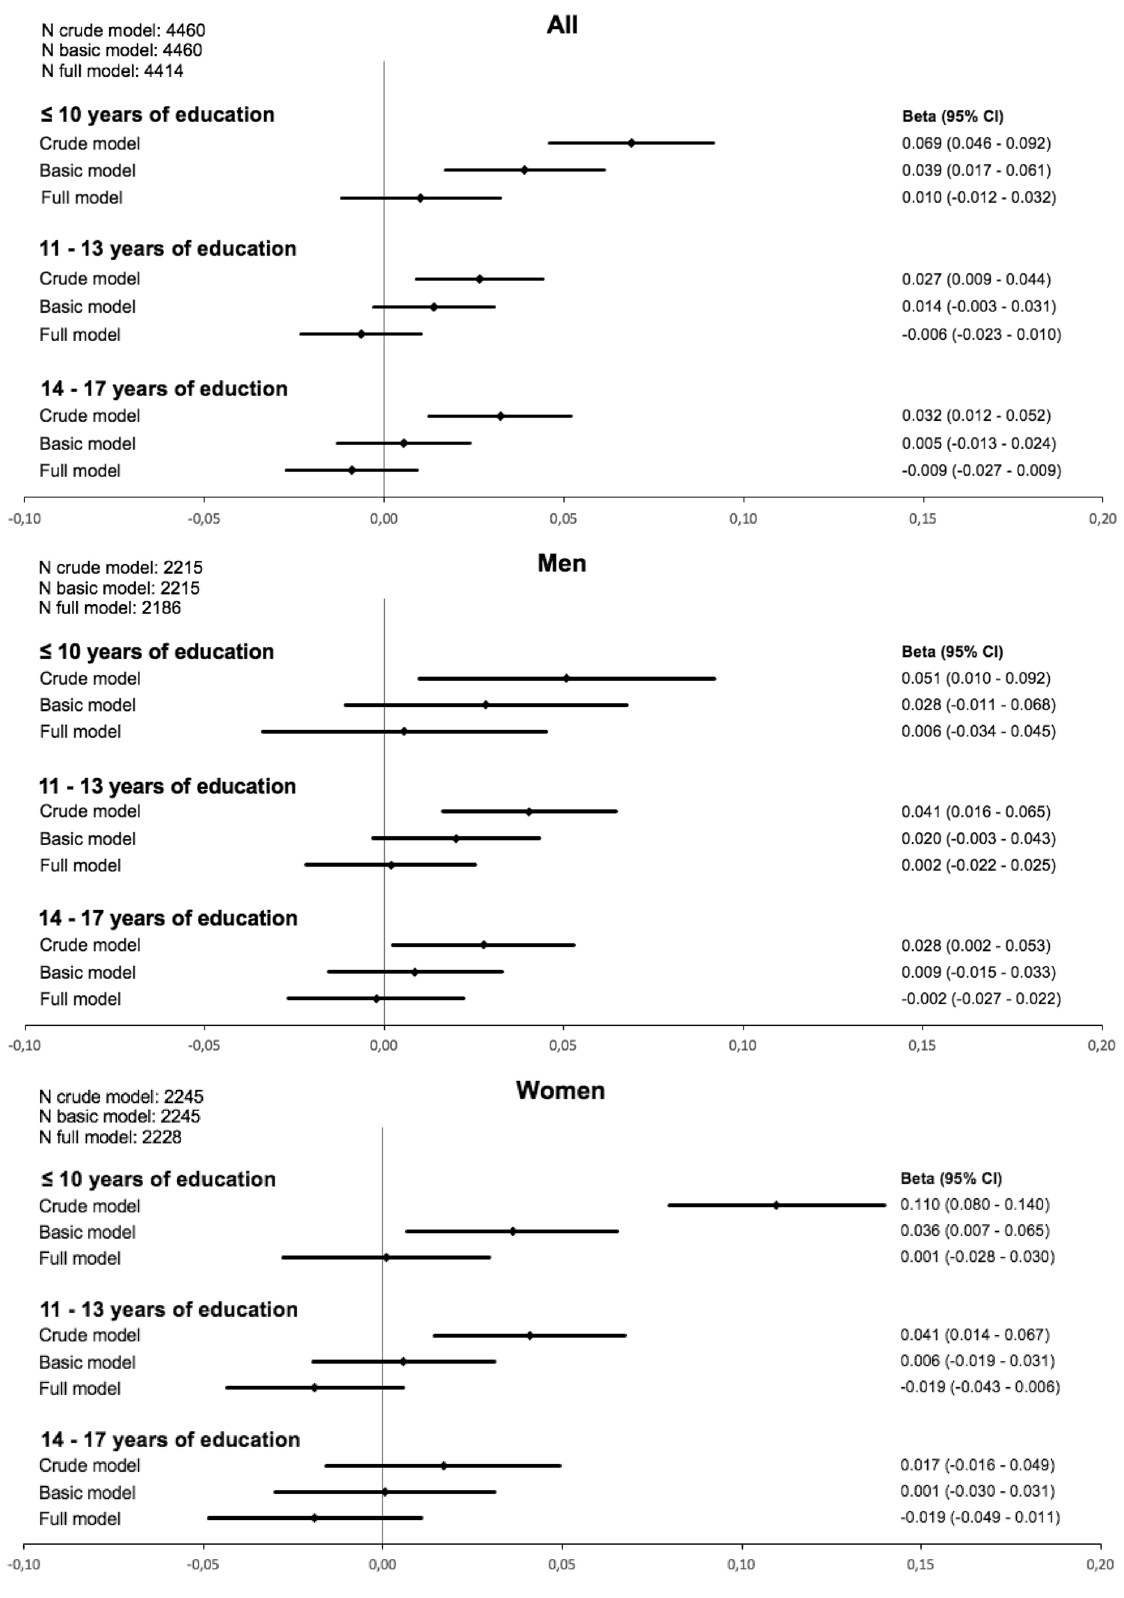
Figure 1. Beta estimates and 95% confidence intervals (95% CI) for the association of education categories (≥ 18 years of education as reference) with cystatin C in linear regression models (basic model: adjusted for age (+ sex); full model: age (+ sex), BMI, hypertension, diabetes, hs-CRP, total cholesterol, HDL, triglycerides,